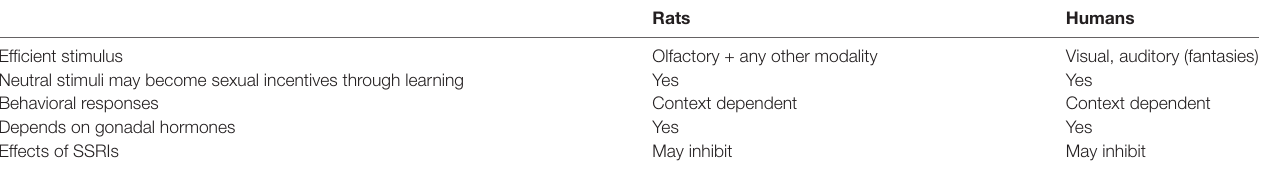
TABLE 2 | Comparison of some basic characteristics of sexual approach behaviors in rodent and humans.